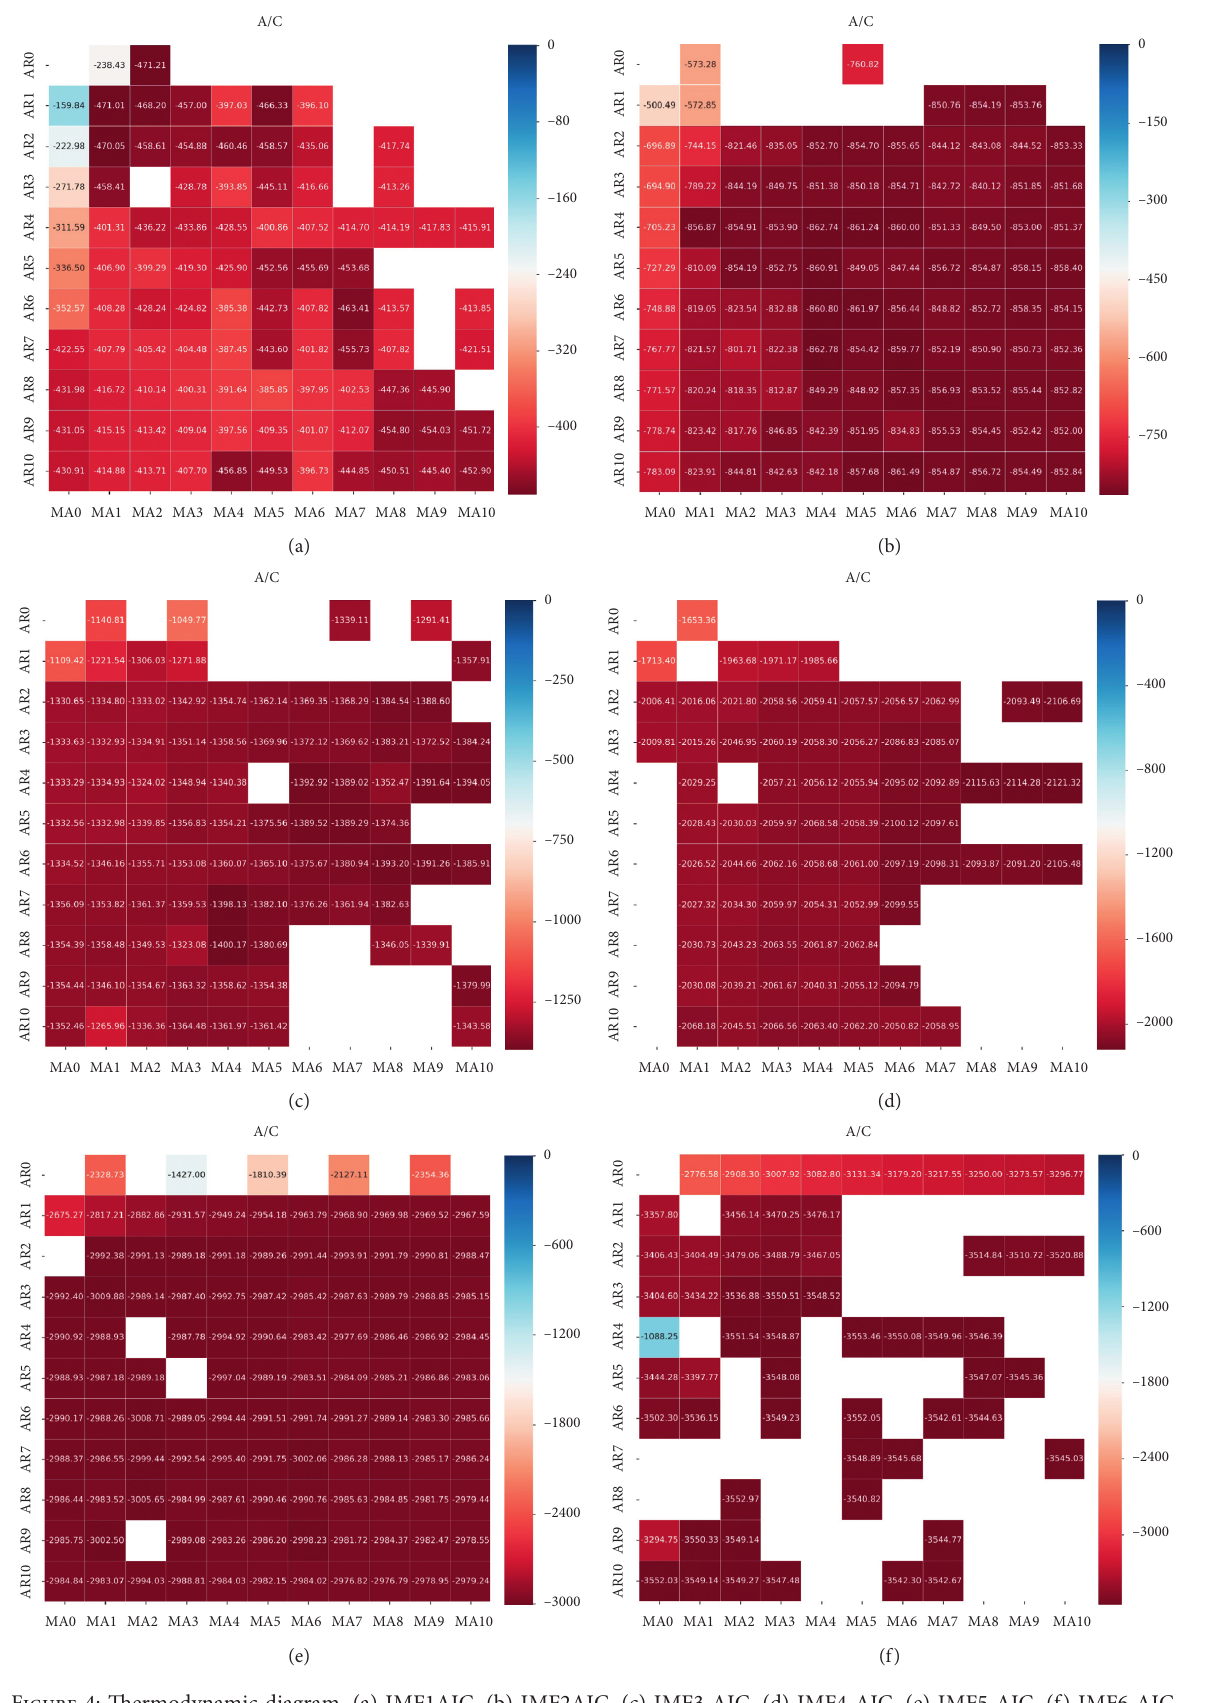
Figure 4: Thermodynamic diagram. (a) IMF1AIC. (b) IMF2AIC. (c) IMF3 AIC. (d) IMF4 AIC. (e) IMF5 AIC. (f) IMF6